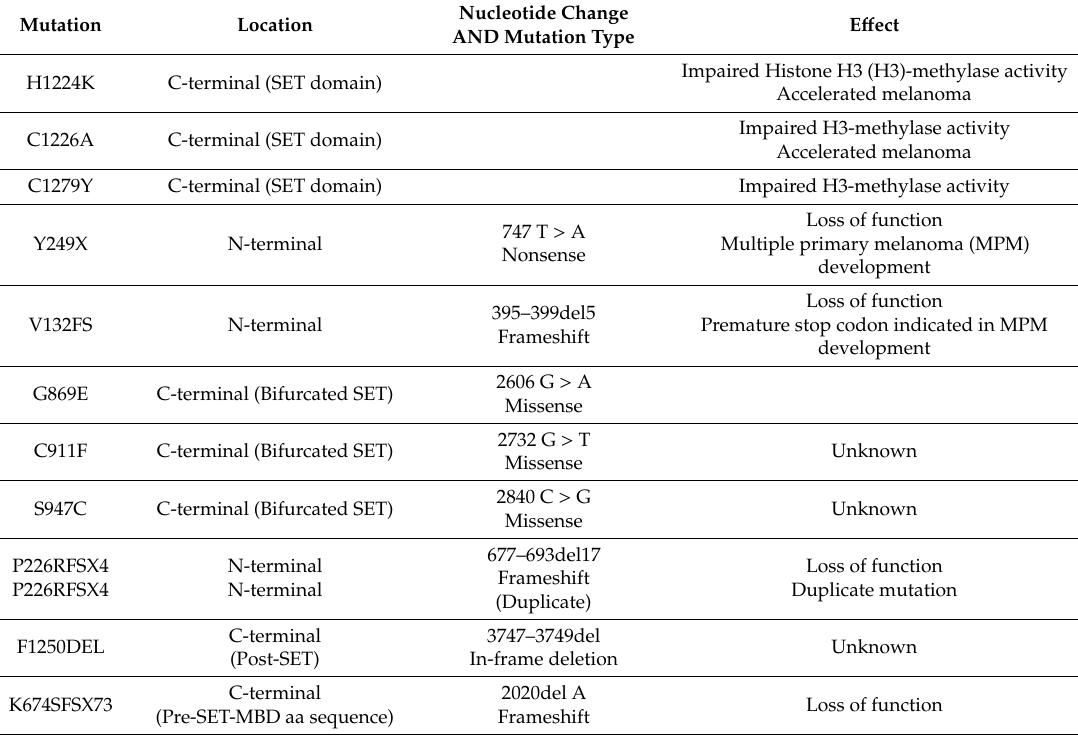
Table 1. Known deleterious mutations of